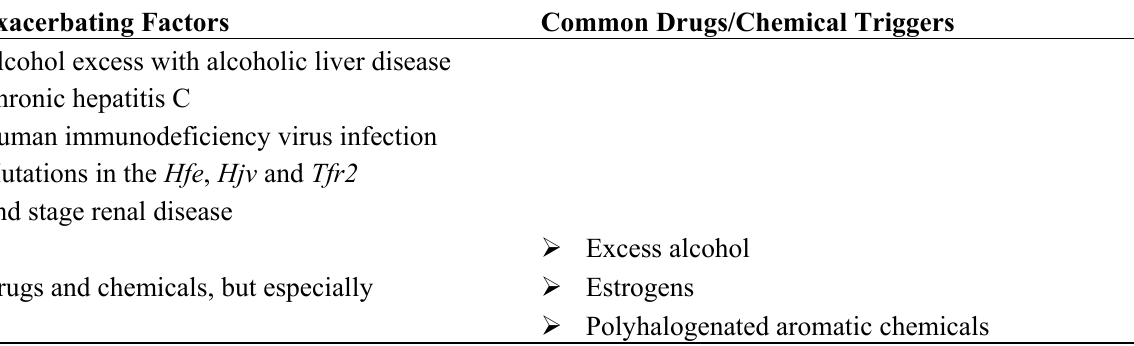
Table 6. Factors known to trigger or exacerbate